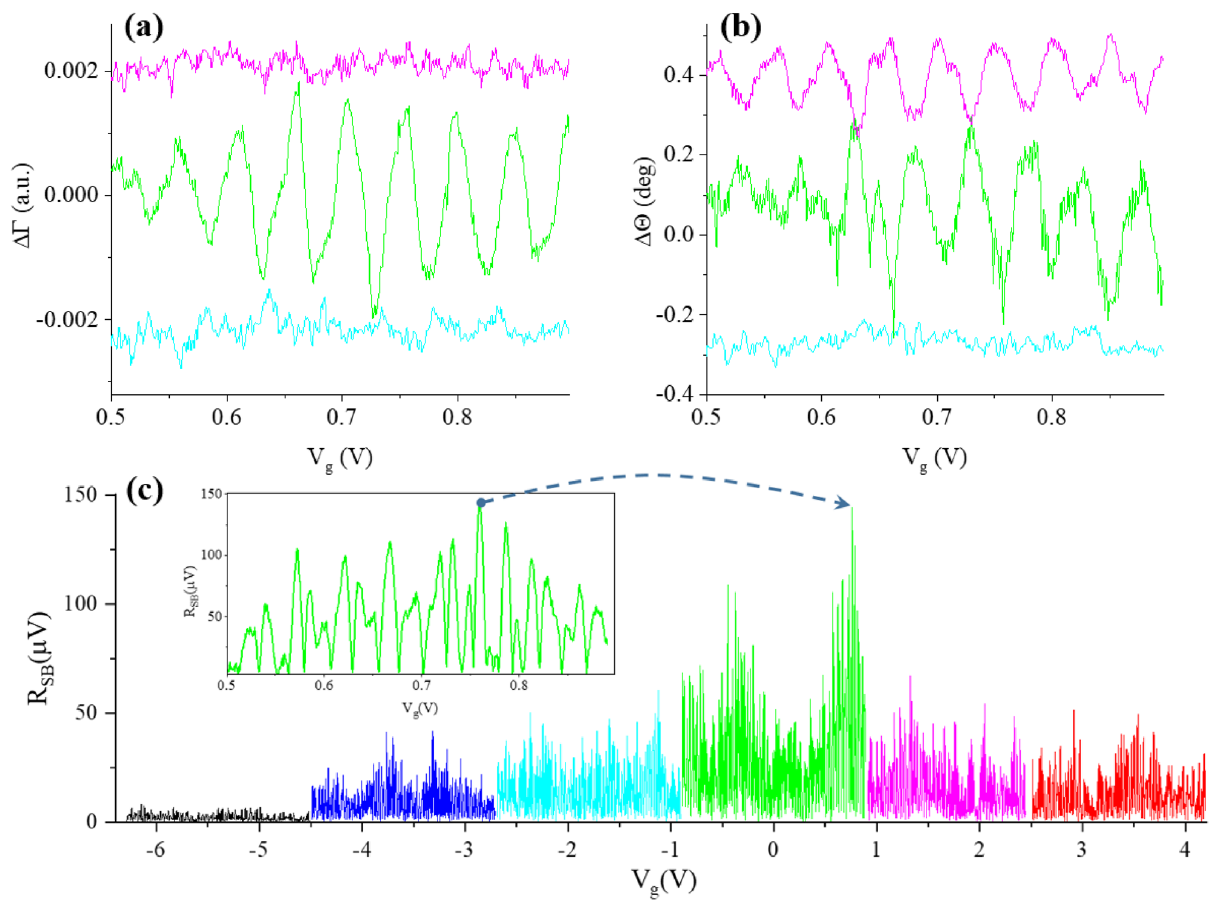
Figure 7. Coulomb blockade oscillations Y ( V g ) of the SEBA measured as magnitude ( a ) and phase ( b ) of reflection at the operating frequency f Op using ECD for three values of the balancing capacitor C IN : 15 pF (light blue), 30 pF (green), 45.8 pF (magenta). Constant values of magnitude and phase are subtracted from each curve to eliminate DC offset and curves are further vertically offset for clarity. Each trace is acquired with 40 ms time constant, no trace averaging is performed. No modulating signal is applied. ( c ) Comparison of SEBA oscillations 0.07 e applied to the gate of SEBA obtained for six Y ( V g ) detected as SB magnitudes for modulating signal ≈ cases of C IN : 0 pF (black); 6.8 pF (blue); 15 pF (light blue); 30 pF (Green); 45.6 pF (magenta); 60 pF (red). Curves are horizontally offset for clarity. T=3.6K. Inset: zoom into beating oscillation pattern for C IN = 30 pF. The arrow points to the working point for C IN = 30 pF, V g =